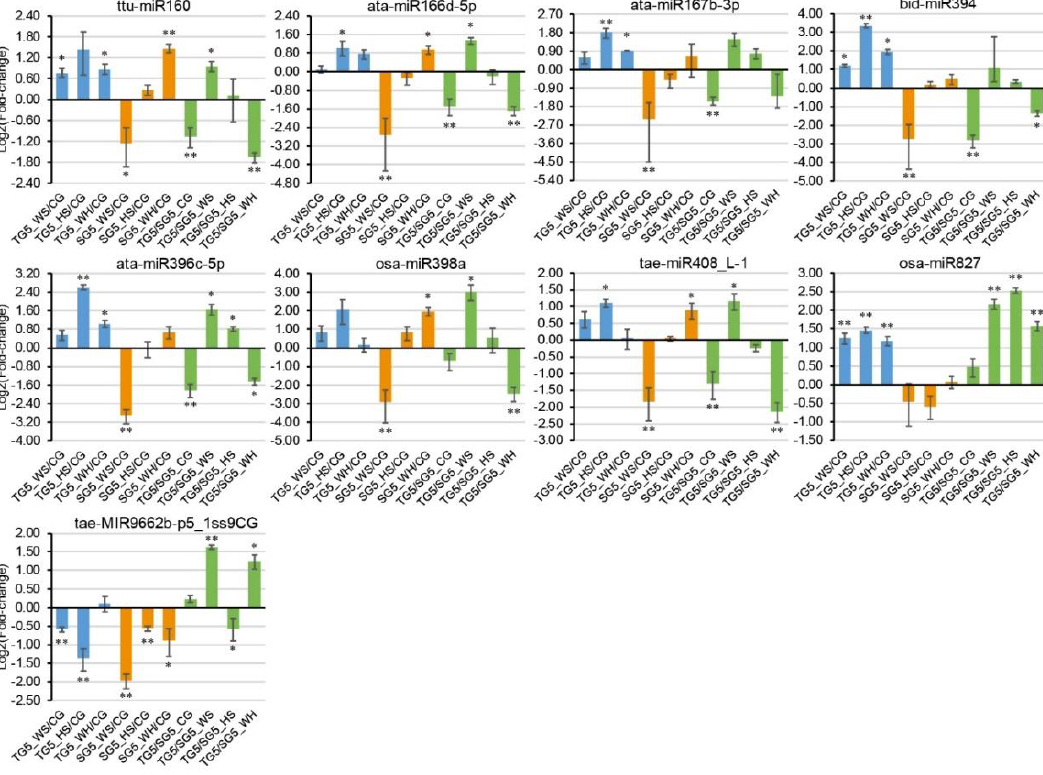
Figure 5. qPCR analysis of nine stress-responsive miRNAs at 5 DPA (days post anthesis). The 2 −ΔΔCt method was used to calculate relative miRNA expression using GAPDH as the housekeeping gene. Each expression profile is shown as the log 2 value of the fold-change, and the fold-change was calculated as follows: (relative miRNA expression level under stress condition)/(relative miRNA expression level under the control condition) or (relative miRNA expression level in DBA Aurora)/(relative miRNA expression level in L6). Data are represented as the mean ± standard error (SE) (three replicates). * p < 0.05, ** p < 0.01 .